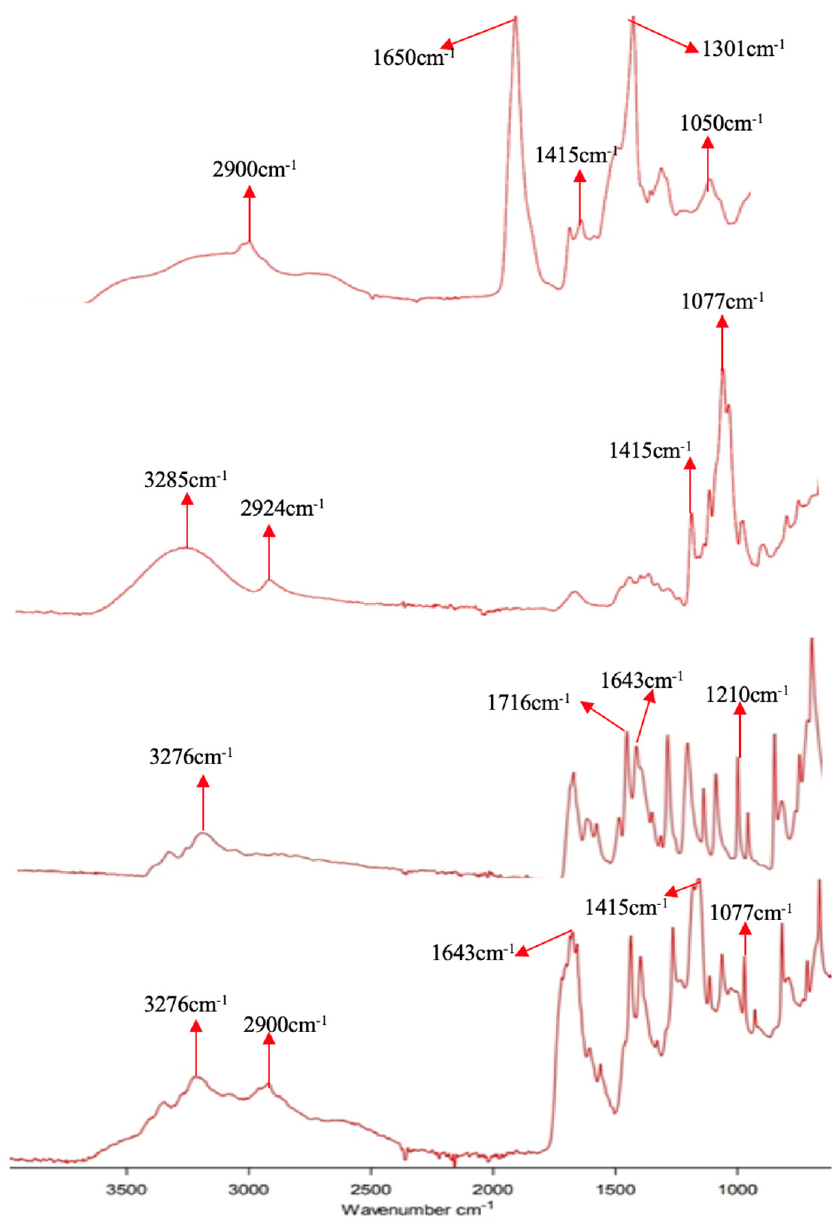
Figure 9. The FTIR spectra of (A) β -CD hydrogel (unloaded hydrogel) reviled the emergence of a new peak at 1052 cm − 1 that confirmed the development of the hydrogel network by the formation of a link between the OH of β -CD and the COOH group of acrylic acid. B describes the FTIR spectrum of β -CD, C shows the spectrum of pure drug (favipiravir), and D illustrates the spectrum of drug-loaded β -CD hydrogel. The presence of favipiravir’s characteristic peaks in the drug-loaded hydrogel confirmed the compatibility of the drug with